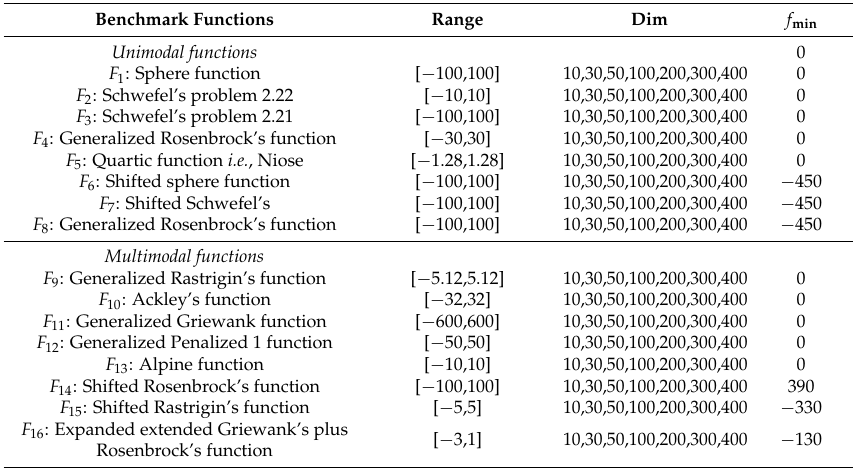
Table 2. Benchmark functions.